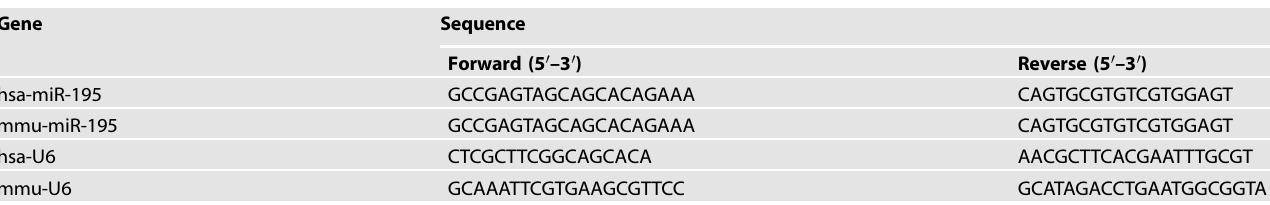
Table 2. The primer sequences for qRT-PCR in this